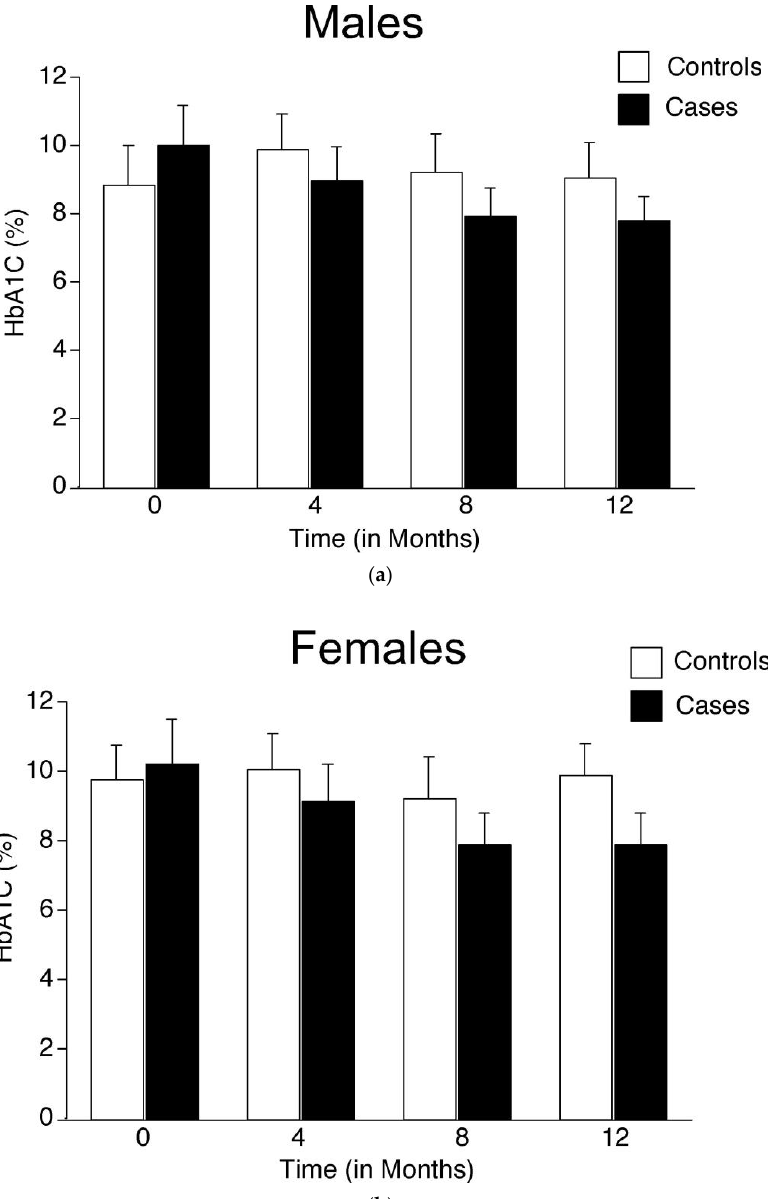
Figure 1. ( a ): Variations in HbA1C (%) values among male participants of the study across different time points: Analysis of the impact of providing phone call based education to male participants showed a visible decrease in HbA1C value at 12 months compared with the control group as well as the baseline HbA1C value within the group. The HbA1C value between the control and case groups was not significant at all time points ( p > 0.05 by Student’s t -Test). However, a non-significant decrease in the HbA1C was observed in the case group at the fourth, eighth, and twelfth months of intervention ( p > 0.05 by Student’s t -Test); ( b ): Variations in HbA1C (%) values among female participants of the study across different time points: Analysis of the impact of providing phone call-based education to female participants showed a visible decrease in HbA1C value at the eighth and twelfth months compared with the control group. The HbA1C value between the control and case groups was not significant at all time points ( p > 0.05 by Student’s t -Test). However, a non-significant decrease in the HbA1C was observed in the case group at the fourth, eighth, and twelfth months of intervention ( p > 0.05 by Student’s t